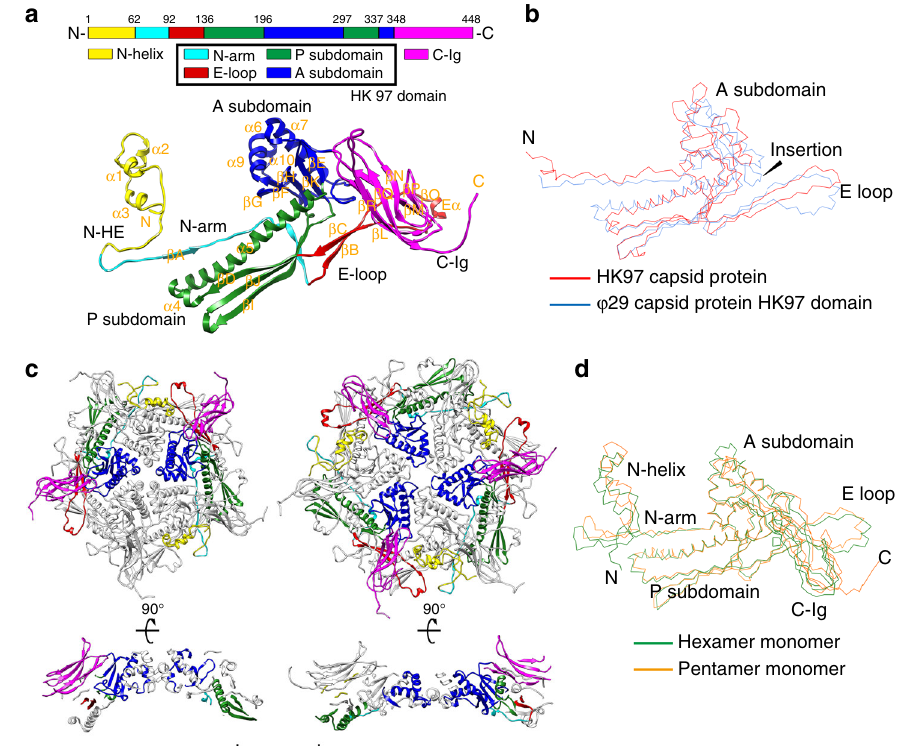
Fig. 2 Structure of the mature capsid. a Structure of the mature virion major capsid protein gp8. Top: a schematic diagram showing the polypeptide chain of a gp8 monomer; bottom: a ribbon diagram of a gp8 monomer structure in a pentameric capsomer. The structural domains of gp8 are shown in yellow (N- helix), cyan (HK97-N arm), red (HK97-E loop), green (HK97-P), blue (HK97-A), and magenta (C-Ig). b Structural superposition of the ϕ 29 HK97 domain (blue) and the HK97 capsid protein (red). c Top and side view ribbon diagrams of a pentameric capsomer and a hexameric capsomer. The structural domains of two gp8 monomers in the pentameric capsomer and three gp8 monomers in the hexameric capsomer are colored in the same manner as in a . The scale bar represents 5 nm. d Structural superposition of a pentameric capsomer monomer (orange) and a hexameric capsomer monomer